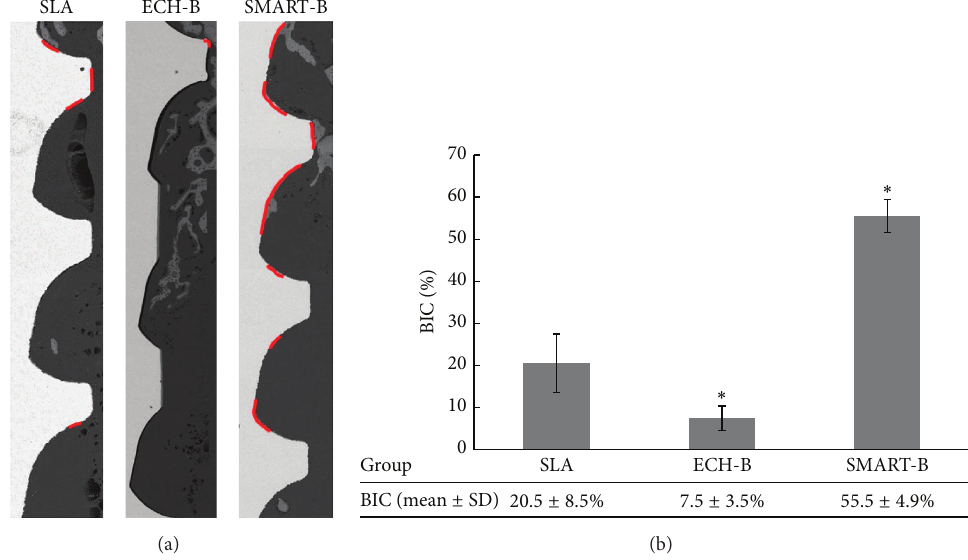
Figure 5: Initial BIC of various Ti implants was analyzed using SEM at 14 days. FE-SEM image (a) shows the BIC in SLA, ECH-B, and SMART-B groups. Statistical summary presenting the BIC estimated means ± standard error for the various implant surfaces (b) (ECH-B: ECH-BMP-2; SMART-B: